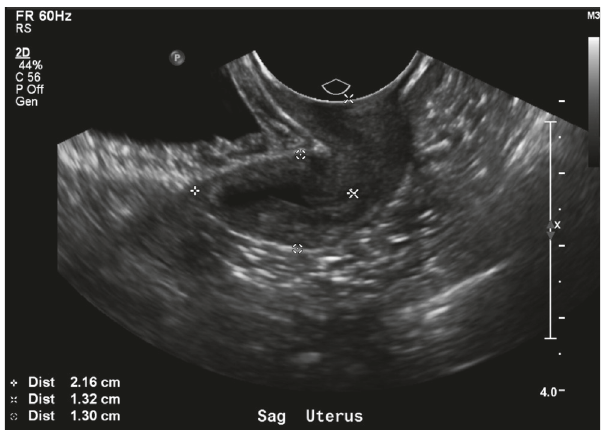
Figure 1: Transvaginal ultrasound of uterus.